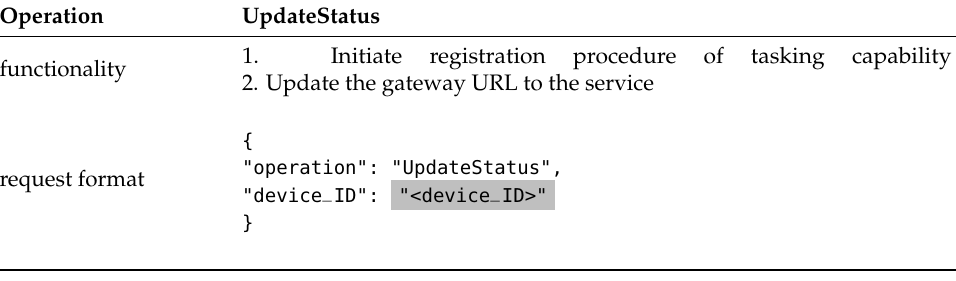
Table 4. UpdateStatus operation.